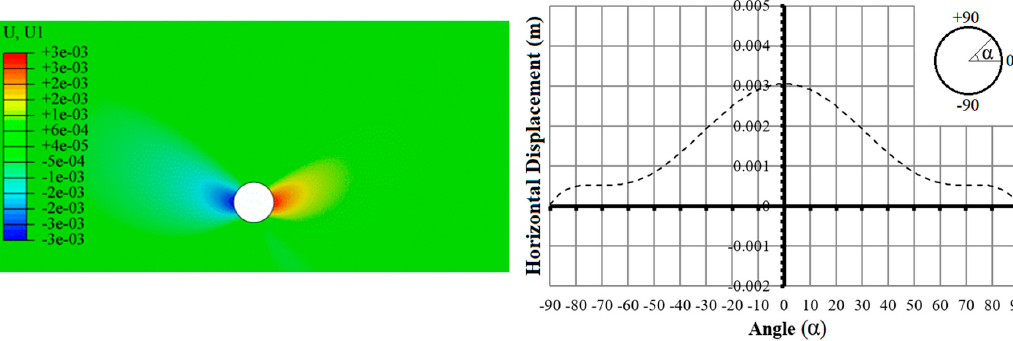
Figure 9. Displacements in the horizontal direction under no-flow conditions.